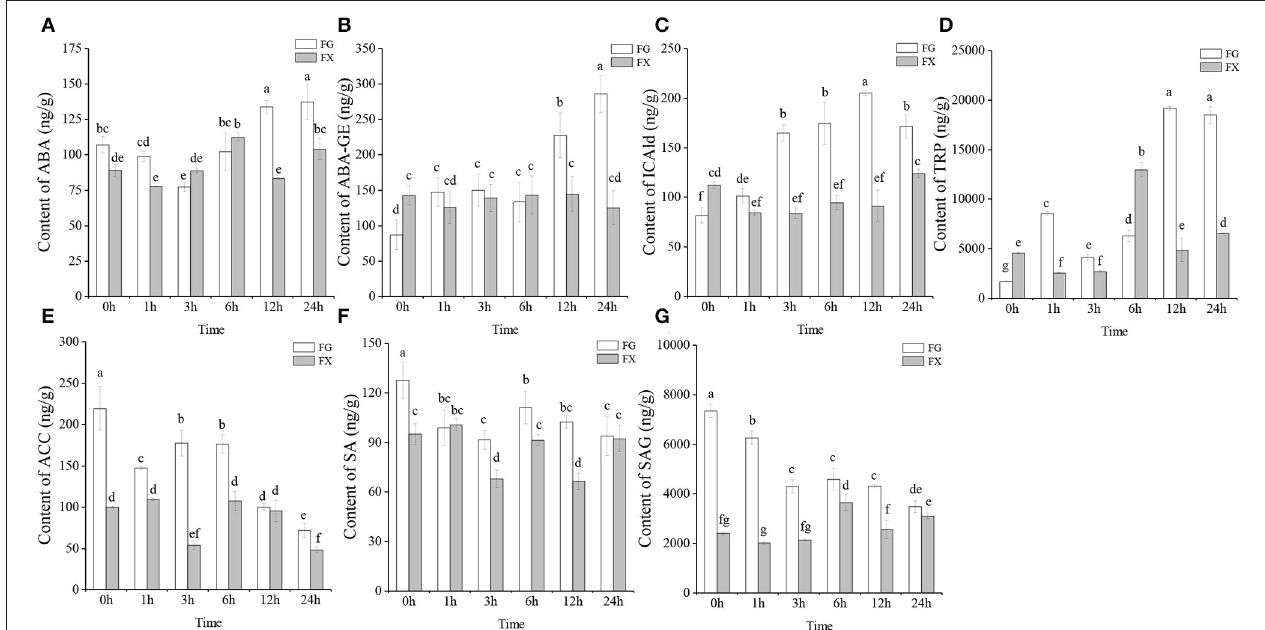
FIGURE 1 | (A–G) The main plant hormone components in cold-tolerant variety FG and cold-sensitive variety FX of Zanthoxylum bungeanum .